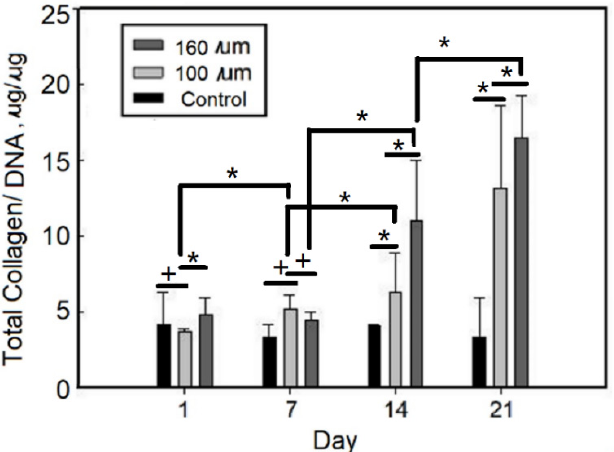
Figure 7. Total collagen/DNA of static culturing chondrocytes on EDC-crosslinked gelatin-based hydrogel scaffolds. Values with different superscripts were significantly different ( p < 0.05); *, statistical significance between the groups ( p < 0.05); +, nonsignificance within the group ( p > 0.05).